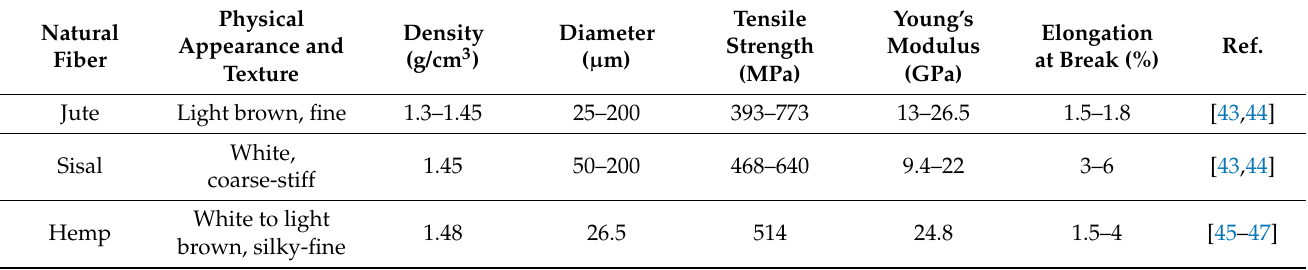
Table 2. Physical and mechanical characteristics of natural